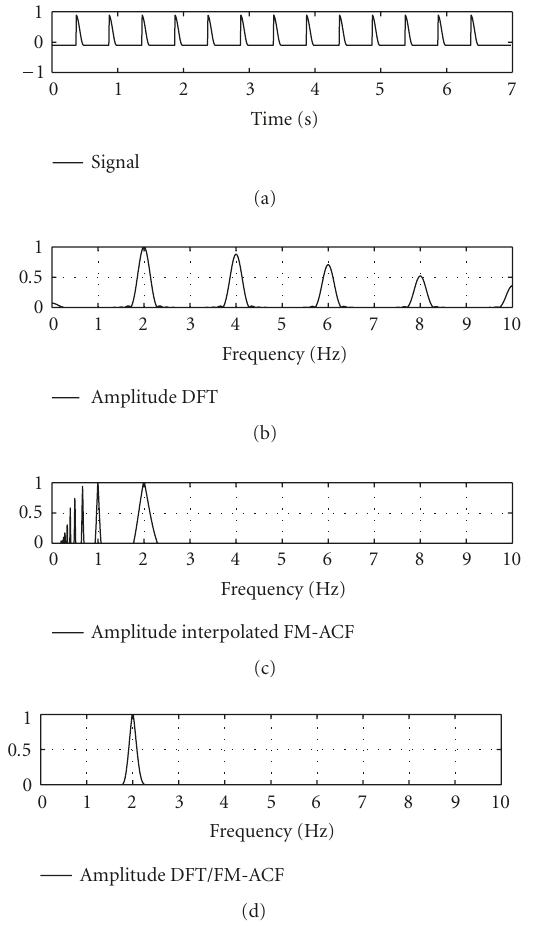
Figure 4: Simple example of combination between the DFT and the ACF. From top to bottom: (a) signal, (b) magnitude of the DFT, (c) ACF function mapped to the frequency domain, (d) product of (b) and (c); on [signal: periodic impulse signal at 2Hz].